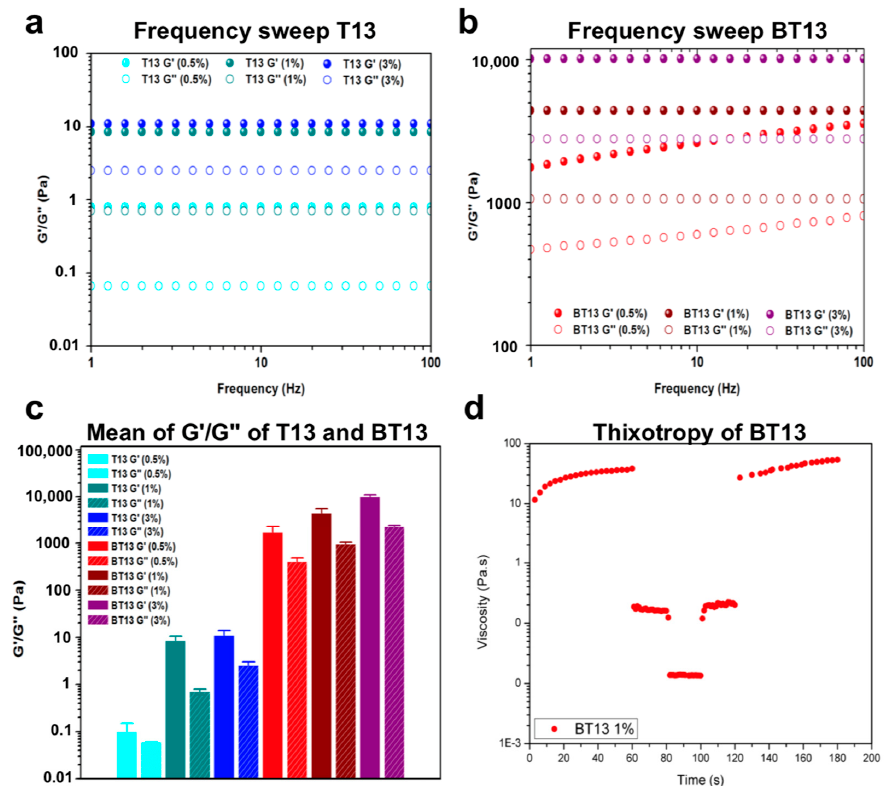
Figure 3. Rheological studies to evaluate the mechanical properties of BT13 hydrogels. Frequency-dependent oscillatory rheology (0.1–100 Hz) of ( a ) T13 and ( b ) BT13 peptides at 0.5%, 1%, and 3% (w/v). ( c ) Average values of storage (G’) and loss moduli (G’’) of T13 and BT13 peptides at 0.5%, 1%, and 3% (w/v). ( d ) Thixotropy test of BT13 hydrogel. This notable increase in the storage modulus of BT13 is likely due to the presence of biotin, which fosters self-assembly propensity, increasing the noncovalent interactions among β -sheet-rich peptide bundles, thus leading to the formation of an entangled and stable nanofibrous network, in accordance with the AFM analysis. It should be noted that above 5% (w/v), the BT13 peptide becomes too viscous and is no longer soluble in water, which is probably due to its high molecular weight (2753.01 g*mol − 1 ). Despite the critical gelling concentration (CGC) of BT13 at 5% (w/v), this pep- tide’s presence improved mechanical properties at low concentrations, which is desirable for biomedical applications in addition to being more cost effective and theoretically more cytocompatible. As a next step, since injectable hydrogels have gained increasing amounts of atten- tion in the fields of biomedicine and bioprinting, and in the delivery of drugs, cells, bi- omolecules, and growth factors due to their minimally invasive delivery method [43], in order to evaluate the propensity of BT13-based hydrogel to recover its initial viscosity after injection, we performed thixotropy tests. In this test, the injection conditions were simulated through a series of constant shear rate tests (see Materials and Methods for further details). We observed that the viscosity of BT13 decreased and nearly returned to original values respectively during and after injection. This rapid viscosity recovery hints at the capability of BT13 to retain the three-dimensional network after gel − sol − gel con- version, particular to thixotropic SAP-based hydrogels.